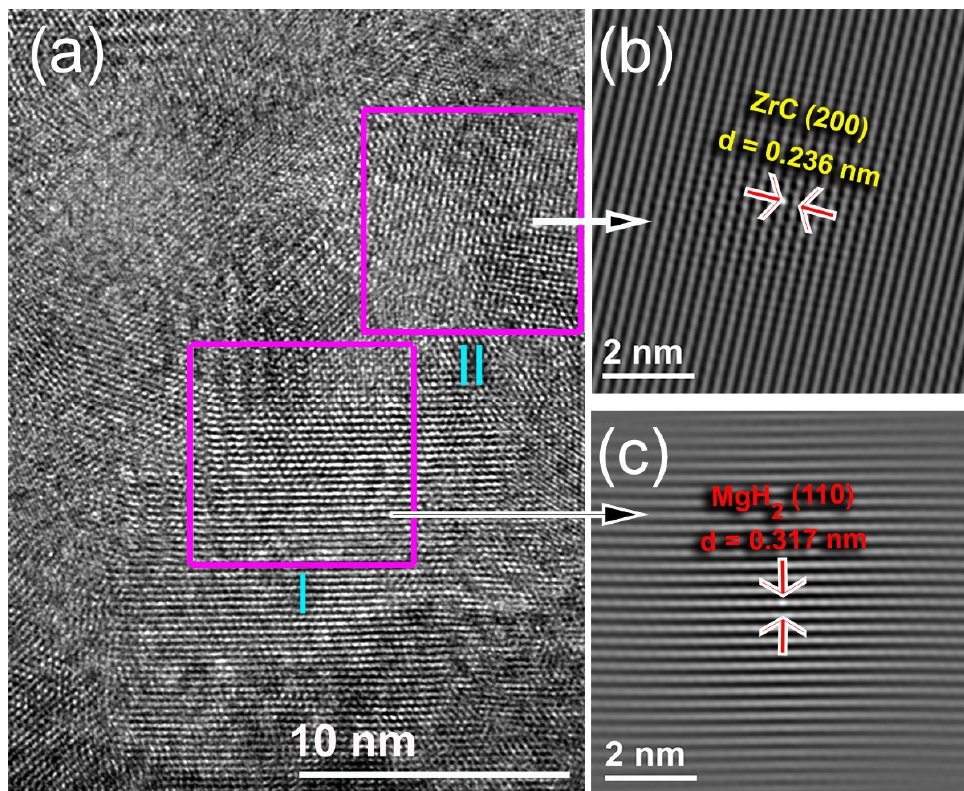
Figure 16. ( a ) FE-HRTEM image of MgH 2 /5 wt.% ZrC binary system, obtained after achieving 1400 h of cycle lifetime at 225 °C under uptake and hydrogen pressures of 10 and 0.4 bar, respectively. The corresponding filtered atomic resolution images taken for zones I and II are displayed in ( b ) and ( c ), respectively.